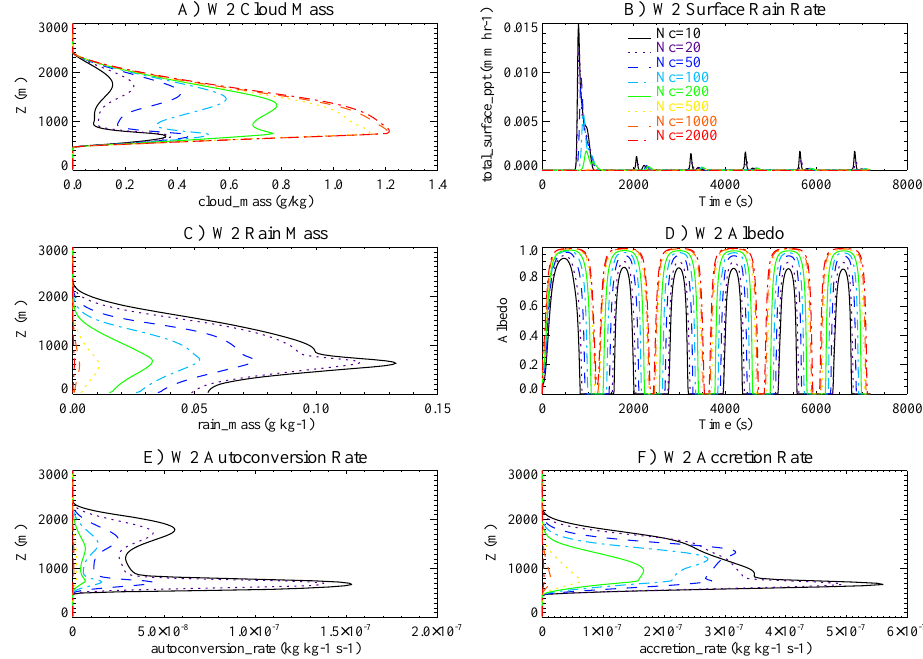
Figure 1. Warm 2 (W2) off-line tests of (a) time-averaged cloud mass (gkg − 1 ), (b) time series of surface rain rate (mmh − 1 ), (c) time- averaged rain mass (gkg − 1 ), (d) time series of albedo, time-averaged (e) autoconversion and (f) accretion rates (kgkg − 1 s − 1 ). Different colors correspond to different fixed cloud drop number